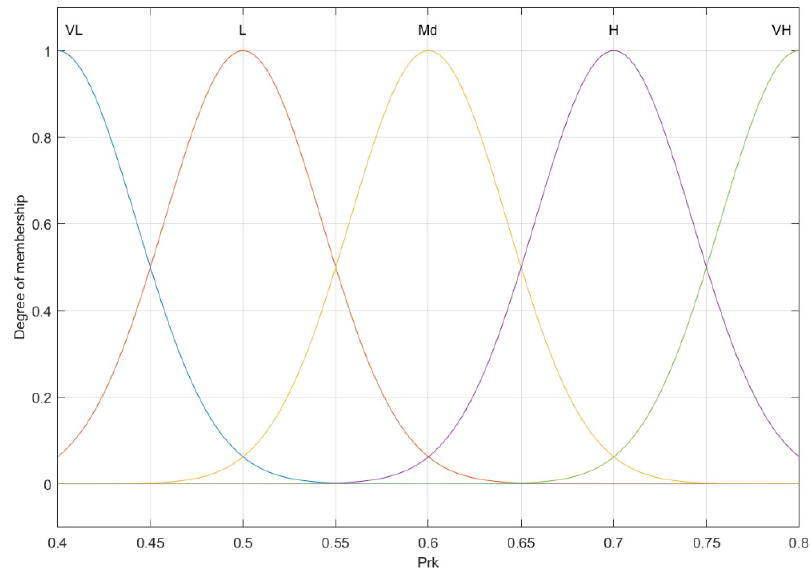
Figure 6. Fuzzy membership function for output P rk .